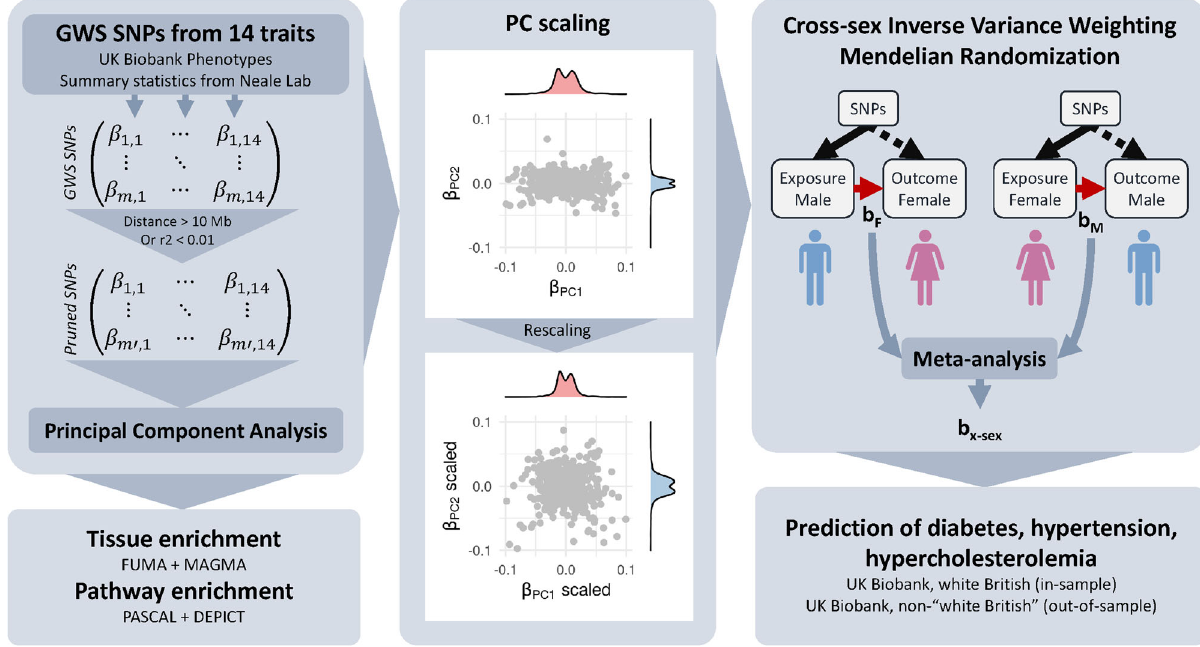
Fig. 1 Overview of the methods. Summary statistics for anthropometric traits from the UK Biobank were pruned for independence before being subjected to principal component analysis (PCA). Principal component-associated SNPs were tested for enrichment in genes expressed in certain tissues or in pathways. The genetic effects on the resulting components were scaled to obtain effect sizes corresponding to a trait with a variance of 1 (standardized). Mendelian randomization was used to determine the impact of these composite traits on lifestyle and health outcomes. Using these effect estimates, the individual risk was predicted in the UK Biobank and accuracy compared to BMI and